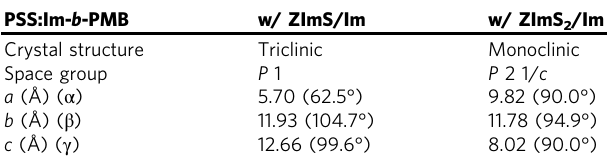
space group, respectively. Miller indices of the re fl ection planes ( hkl ) of each crystal were obtained by Mercury DSD 3.9 software, as given in the fi gure.